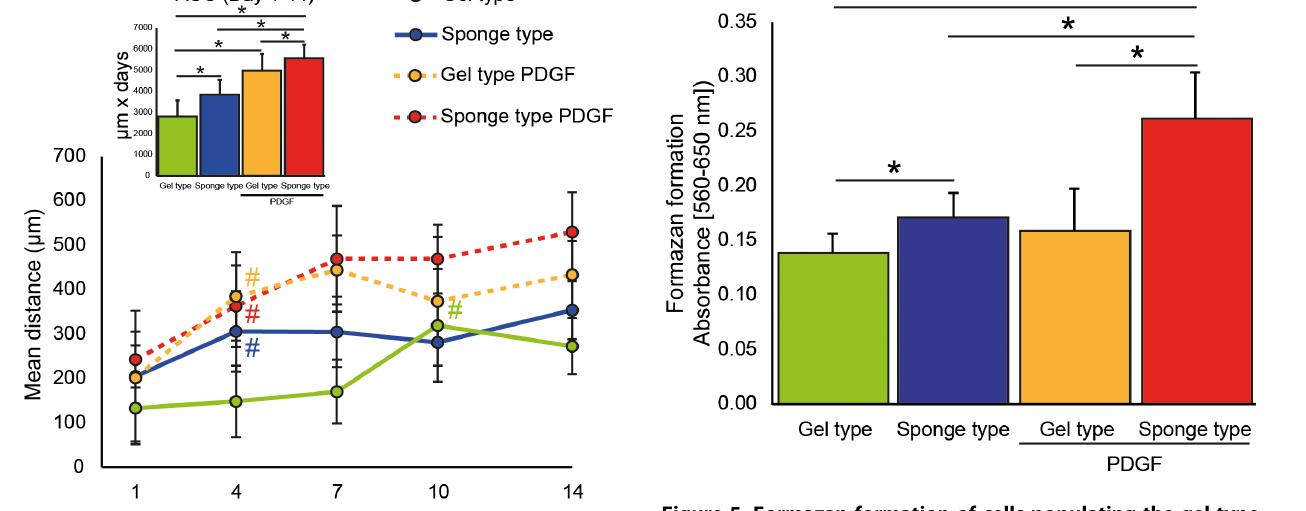
Figure 5. Formazan formation of cells populating the gel type and sponge type scaffolds. Formazan formation in the gel type and sponge type scaffolds with and without platelet-derived growth factor- BB (PDGF) at day 14 was quantified utilizing the MTT assay. Data are given as mean 6 standard deviation. (n=7–8) Data was analyzed using analysis of variance (ANOVA) and Fisher’s protected least significant difference (PLSD) post hoc test. Significance (*) was assigned at p , 0.05.